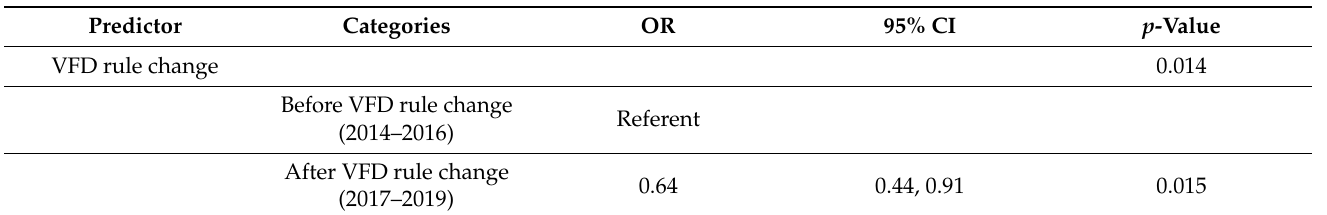
Table 7. Results of multivariable logistic regression for predictors of detection of violative residues of sulfonamides in the tissue of food animals ( n = 901) from the IGS, 2014–2019.